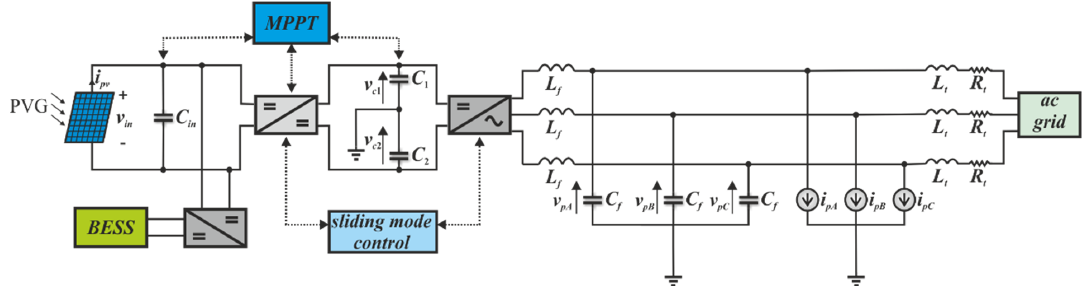
Figure 1. Schematic view of double-stage three-phase photovoltaic (PV) inverter with integrated Battery Energy Storage System ( BESS ).